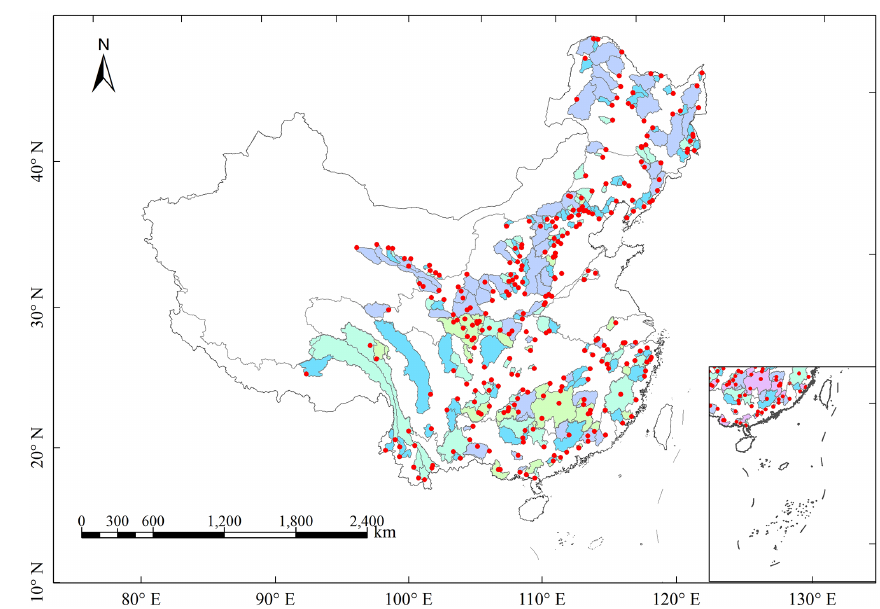
Figure 1. The location of the studied catchments. Red points represent catchment runoff gauge